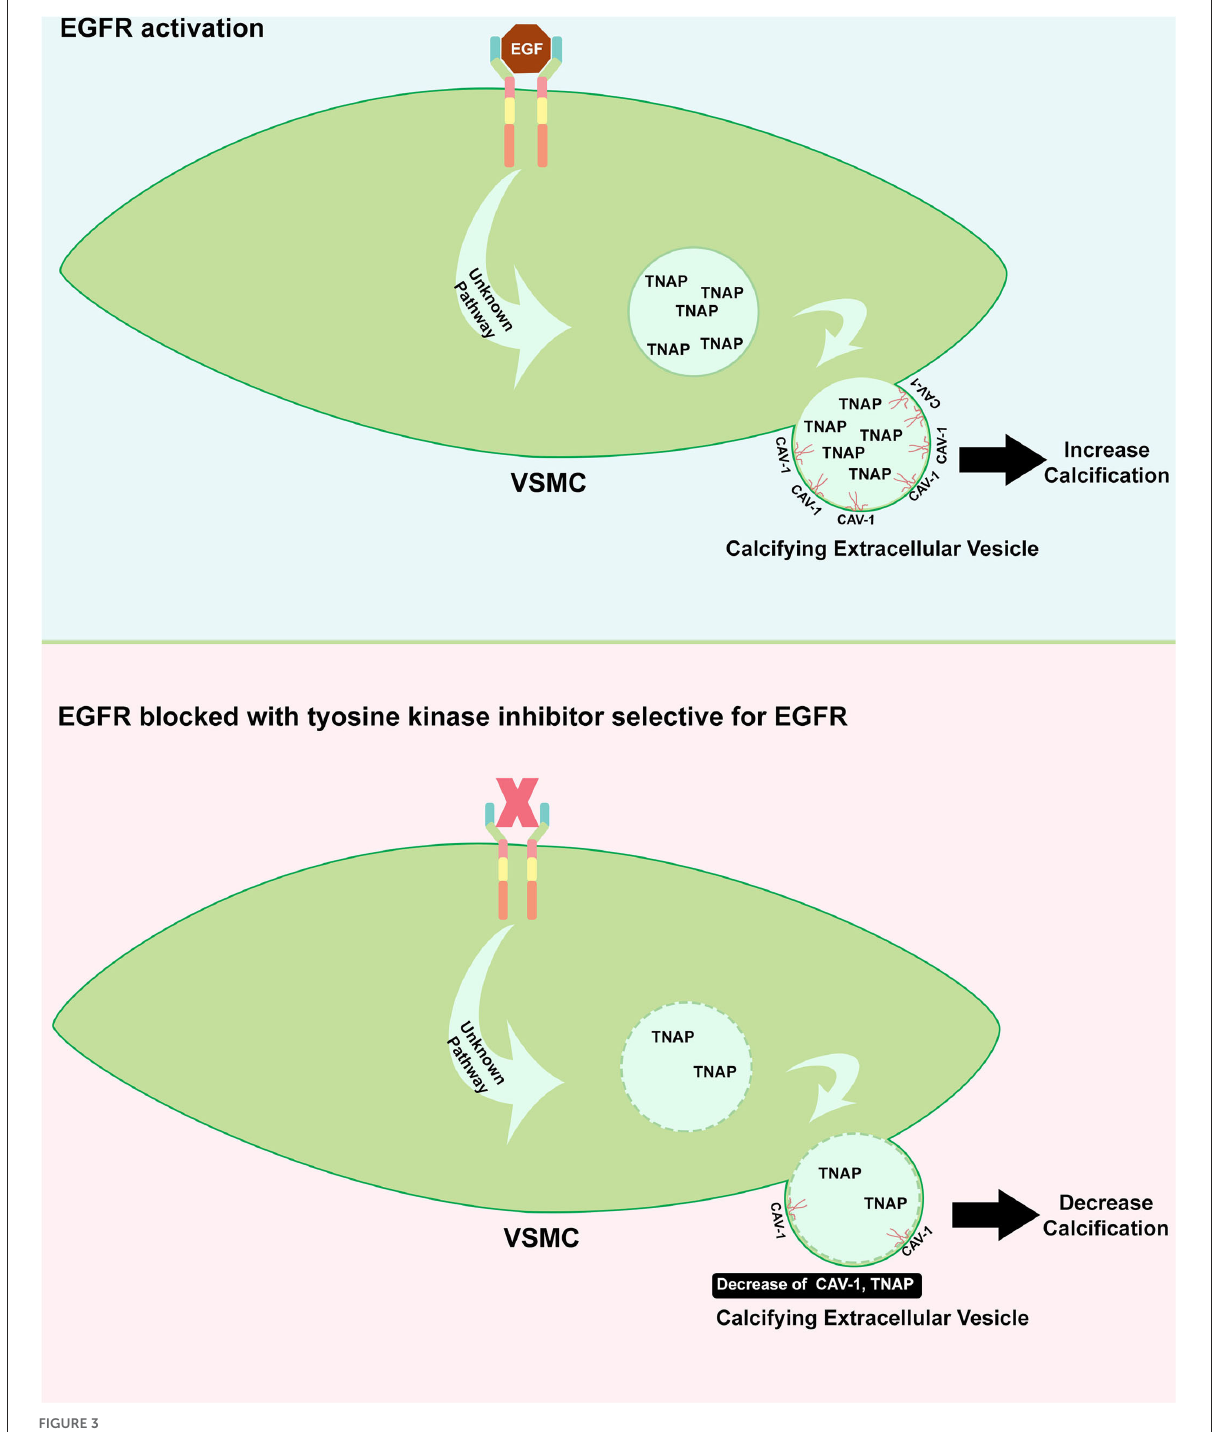
FIGURE3 Role of EGFR in inducing calcification. Upon EGFR activation on VSMC, the formation of CAV-1 positive vesicle is increased including the augmentation of TNAP which can inhibit the calcification inhibitor. The release of this enzyme to extracellular matrix could cause imbalance of inhibitor and inducer of calcification (upper panel) . TKI which specifically target EGFR could benefit the cardiovascular system where it protects the vessel from developing calcification, in part, through the decrease of CAV-1 positive vesicle containing TNAP (bottom panel)